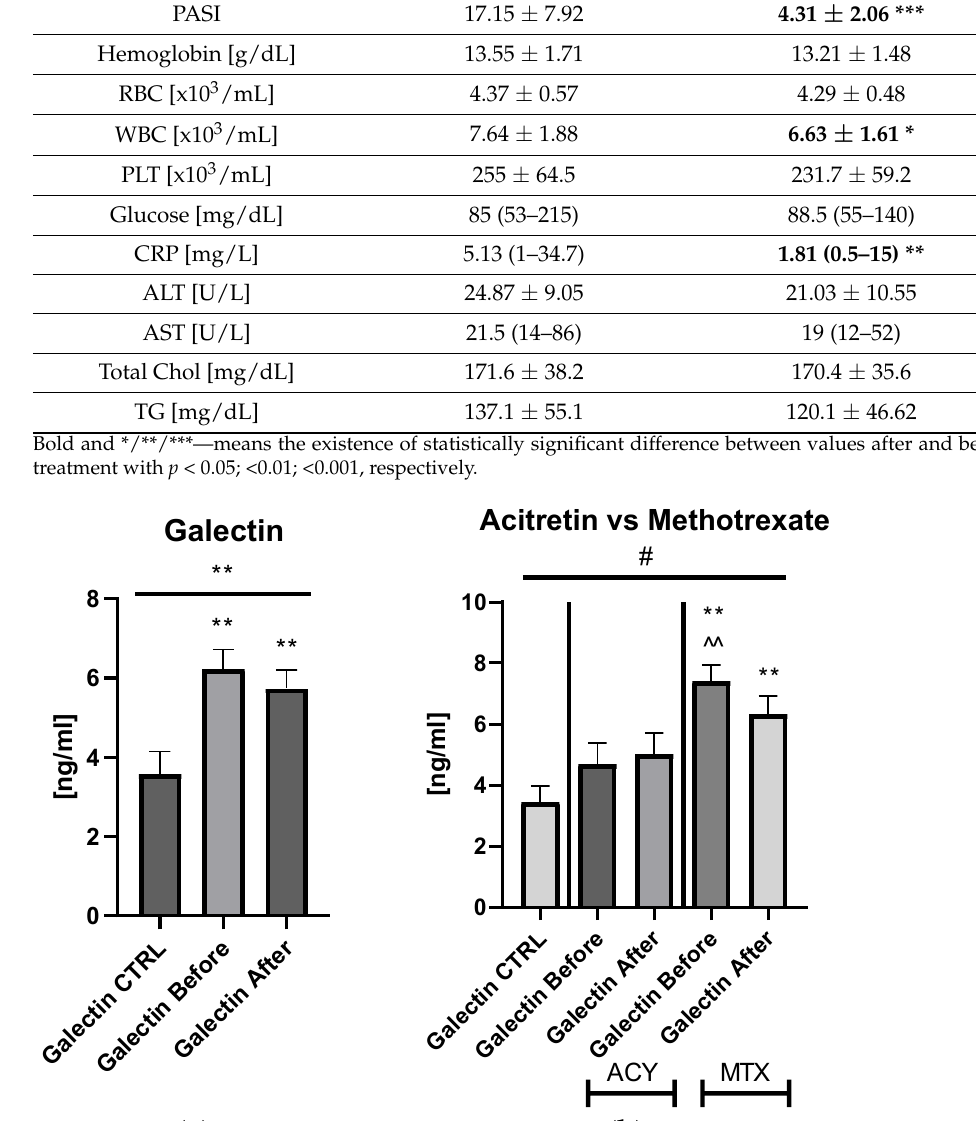
group and divided into subgroups undergoing therapy separately with acitretin and methotrexate ( b ).